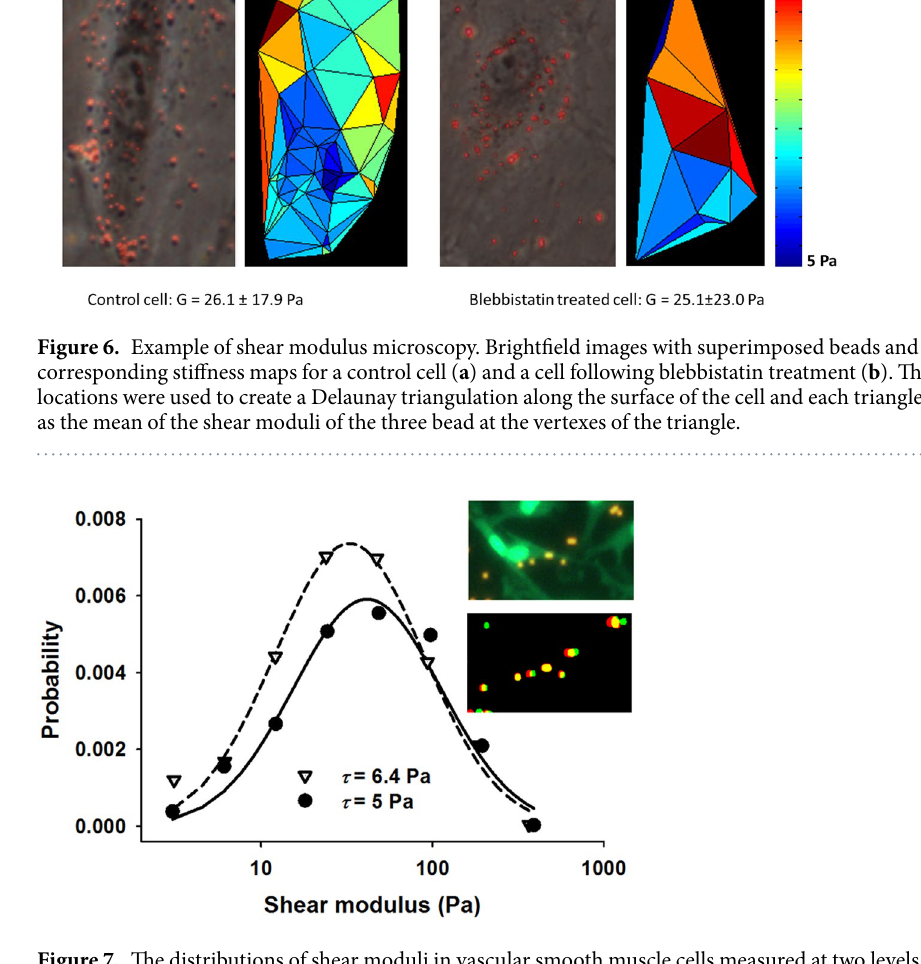
Figure 7. The distributions of shear moduli in vascular smooth muscle cells measured at two levels of shear stress ( τ ). Both distributions are similar to a lognormal distribution. The solid and dashed lines are fits of the lognormal distribution with means of 111.2 and 89.3 and Pa and variances of 2.7 and 2.7 Pa2 for the lower and higher shear stress cases, respectively. The top inset shows several vascular smooth muscle cells (green nuclear/ cytosolic dye) and beads (red/yellow, 2.27 μ m) before flow. The bottom inset shows only the beads before flow (red) and during flow (green, which partly becomes yellow if there is